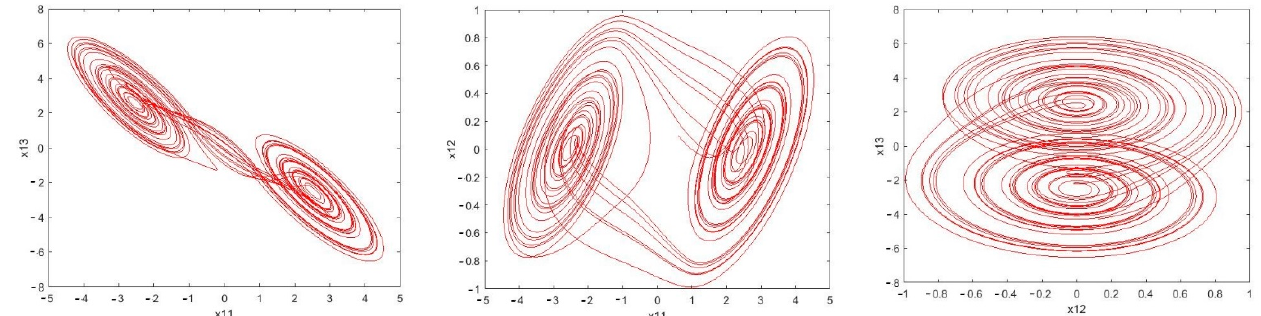
Figure 6. Sample phase curves of the Master system.